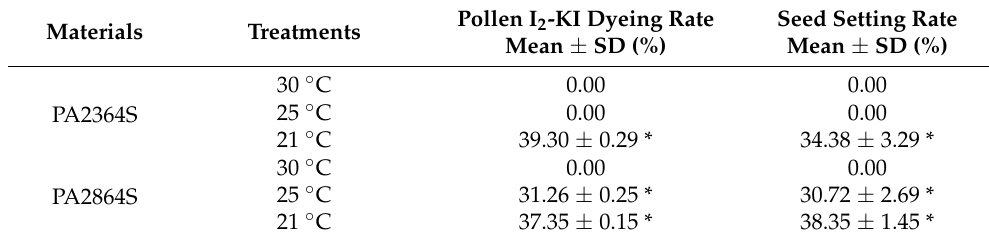
Figure 1. Characteristics of fertile and sterile plants and pollen phenotypes of PA64S. ( A ) The phenotype of PA2364S and PA2864S plants under different temperature treatments. ( B ) Pollen fertility of PA2364S and PA2864S under different temperature treatments. ( C ) Anther phenotypes and electron microscopic observation of pollen grains in fertile and sterile plants. ( I – III ) show anther and SEM and TEM of pollen in fertile plants, respectively. ( IV – VI ) show anther and SEM and TEM of pollen in plants, respectively. SG, starch granule; In, intine; Ne, nexine; Ba, bacula; Te, texine; Ub, Ubisch body. 23 °C-P23-F. Fertile plants under 23 °C treatment in PA2364S. Table 1. Pollen fertility and seed-setting rate of PA2364S and